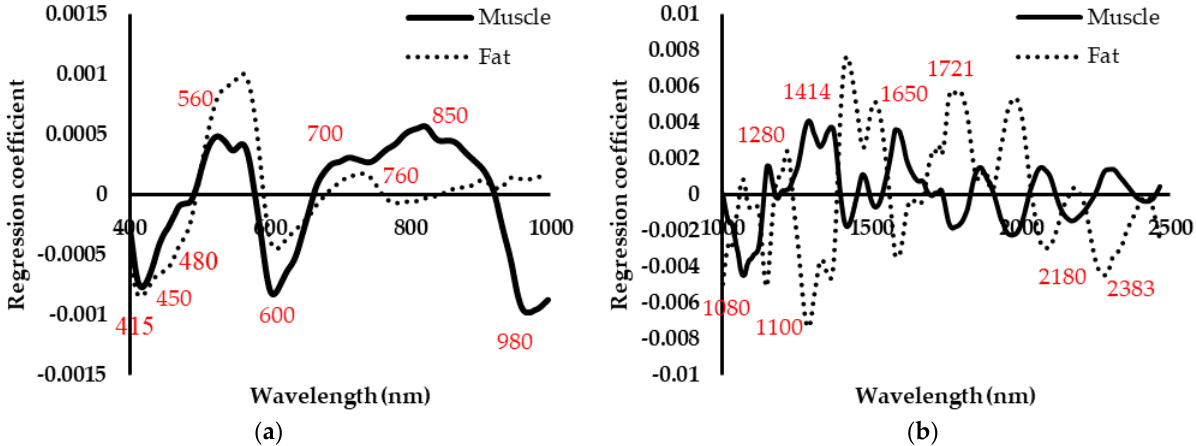
Figure 6. Selection of key wavelengths for discriminating chicken fillet from other materials. ( a ) VNIR range muscle and fat and ( b ) SWIR range muscle and fat related key wave bands.